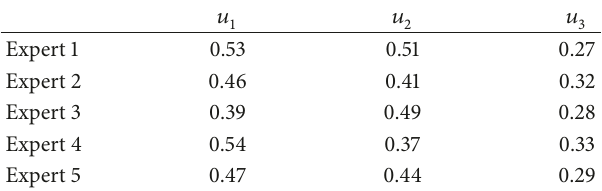
Table 3: Membership grades of different evaluation indices.